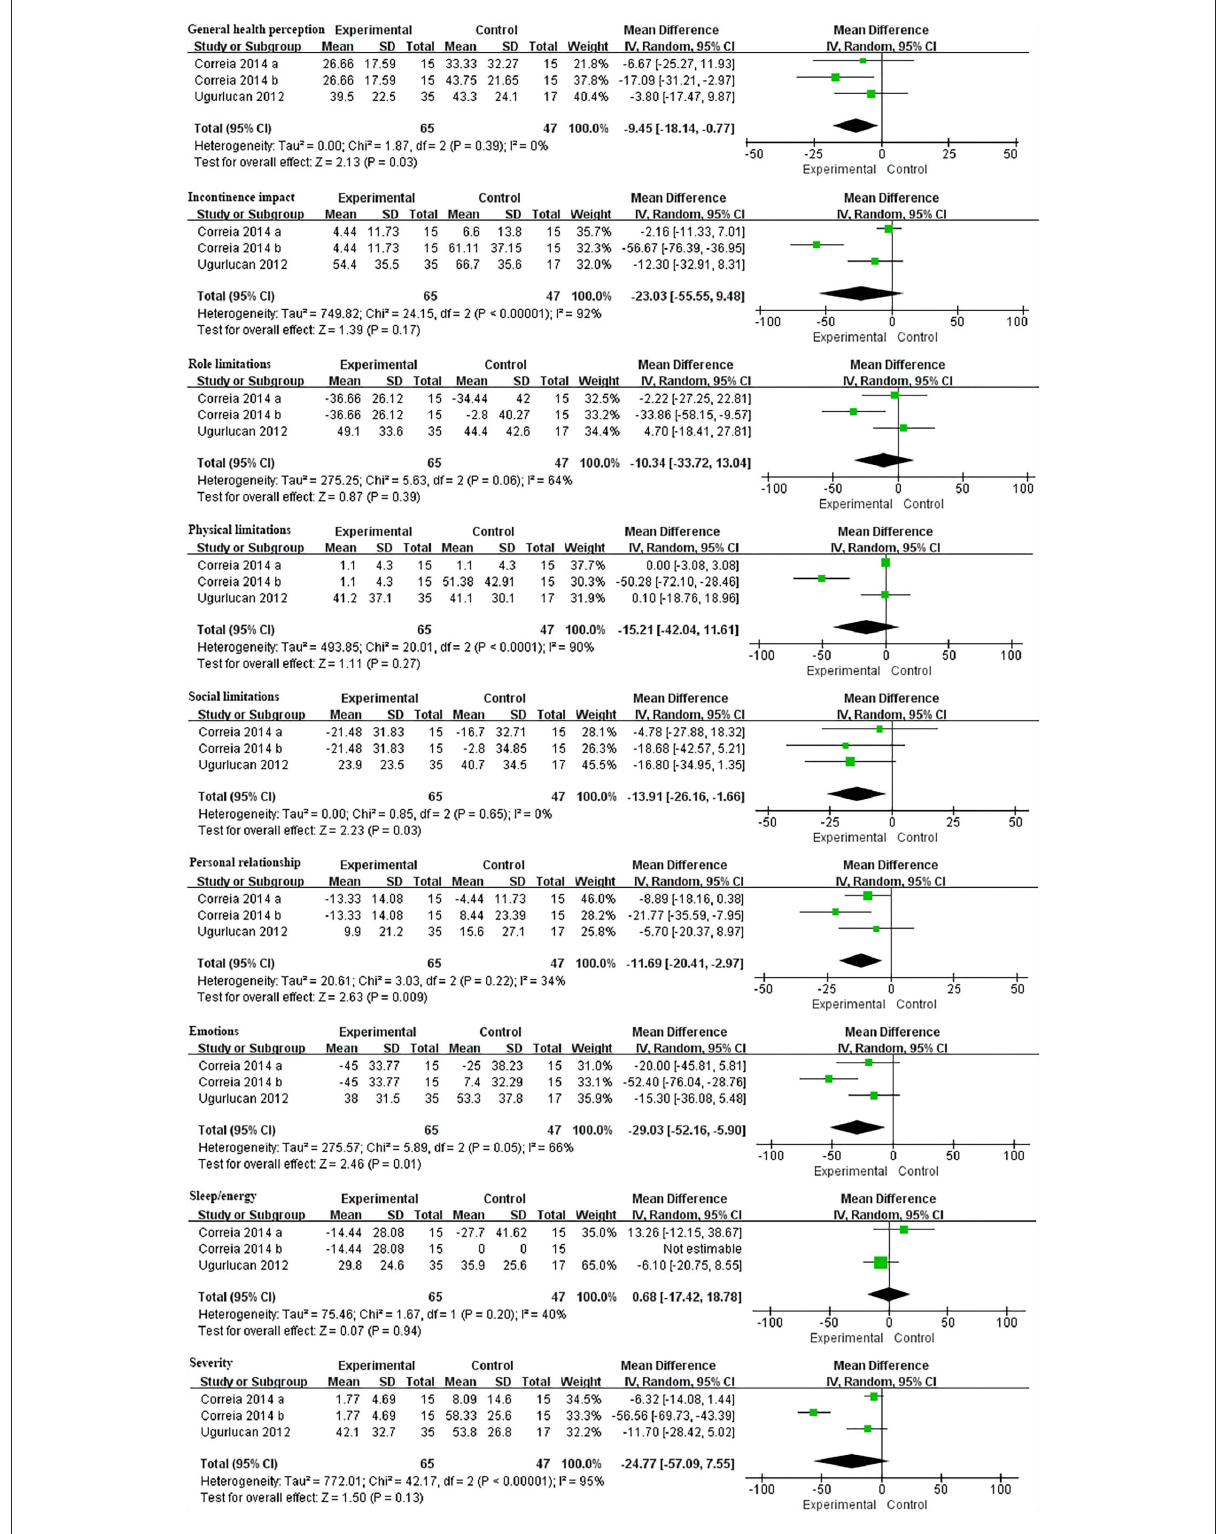
FIGURE6 Forest plots showing the changes of various indexes in King’s health questionnaire after IVES treatment. SD, standard deviation; IV, inverse variance; CI, confidence interval; df, degrees of